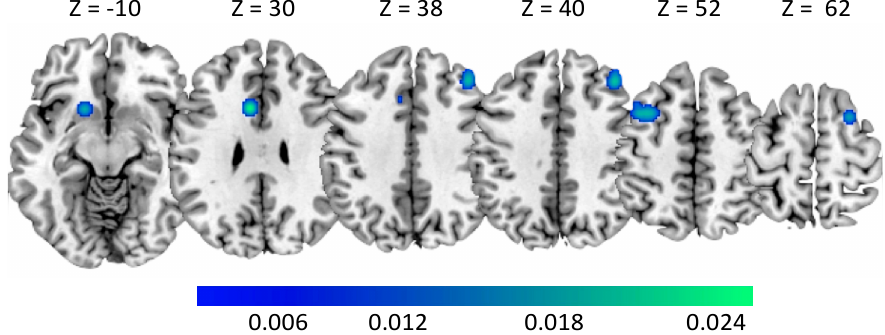
Figure 4. Clusters of deactivation in Alcohol Use Disorder subjects. MNI coordinates are provided. The color bar indicates ALE values.